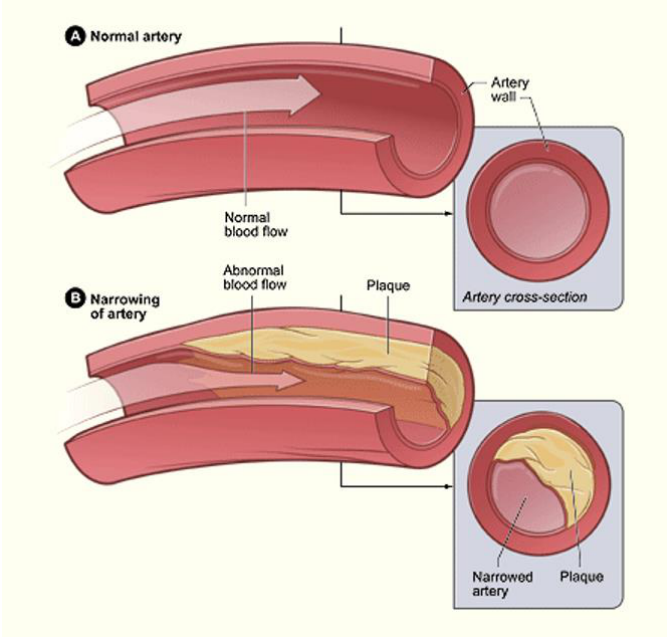
Figure 8. Although able to exist singularly, lipid-based plaques and calcified plaques are often complementary in the narrowing of arteries. This narrowing is illustrated through the contrast of the normal artery ( A ) and the narrow artery ( B ) [122]. normal artery ( A ) and the narrow artery ( B )